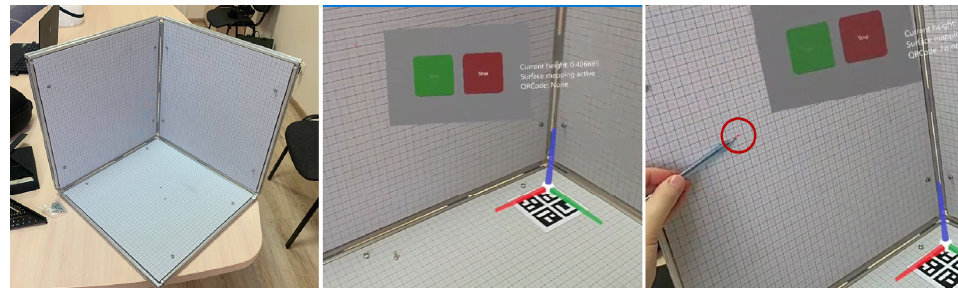
Figure 12. The stand for measuring positioning accuracy (left). The marker is placed in predefined spot (center). Three different 1-mm spheres are visualized on the each side of the stand. The deviation around 2–3 mm can be seen on the right image by comparing the pointer position (where the sphere should be) with actual sphere position (red dot). The step of the grid is 1 mm.